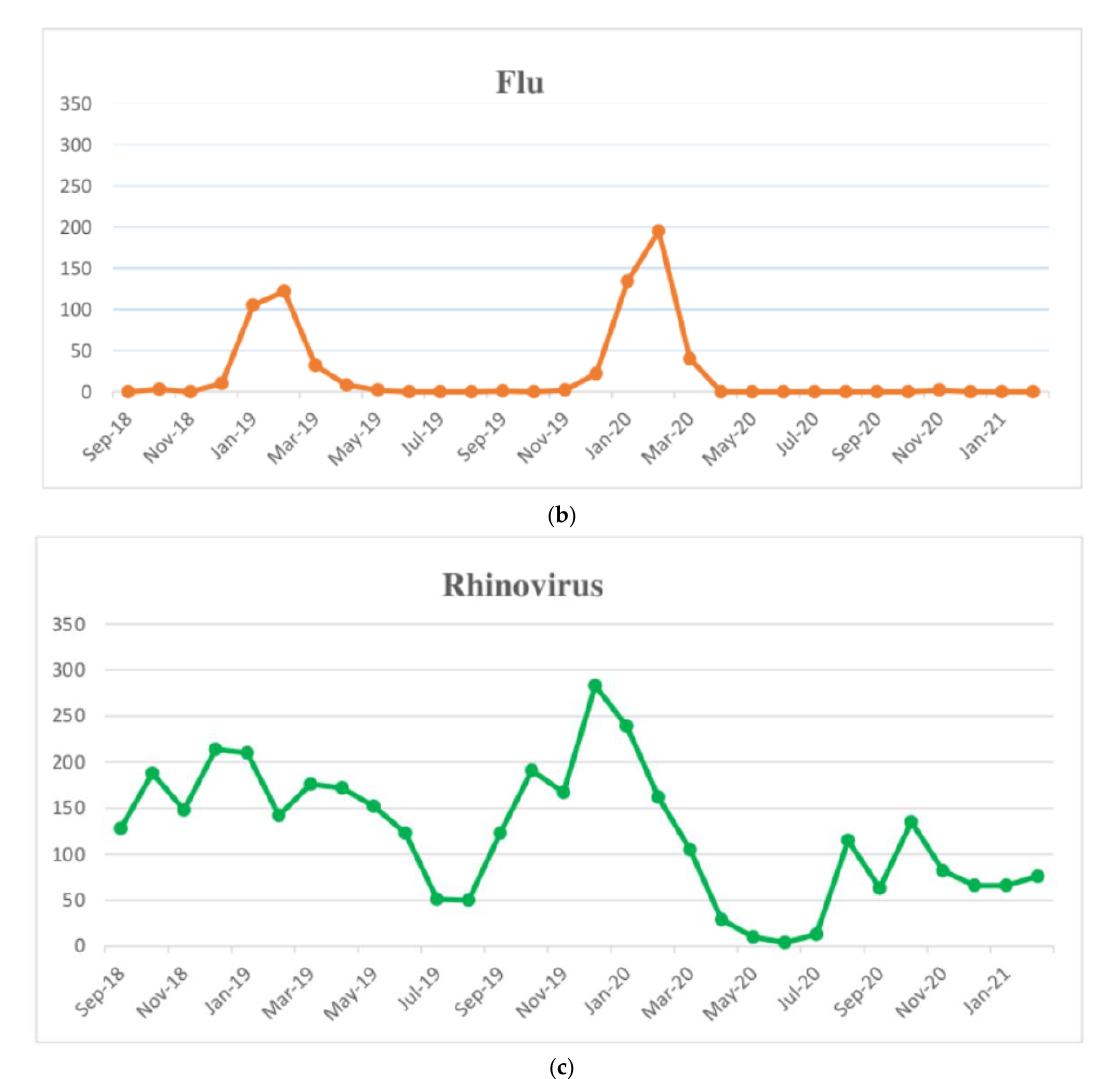
Figure 1. The cyclical trend of RSV ( a ), flu ( b ), and Rhinovirus ( c ) during the last 3 years. During the season 2018–2019 and 2019–2020, the total number of RSV cases was, respectively 726 and 689, while in the last season only five cases were detected. RSV detec- tions in 2020–2021 were 99.31% and 99.27% lower compared to 2018–2019 and 2019–2020, respectively ( p = 0.016 and p = 0.016).